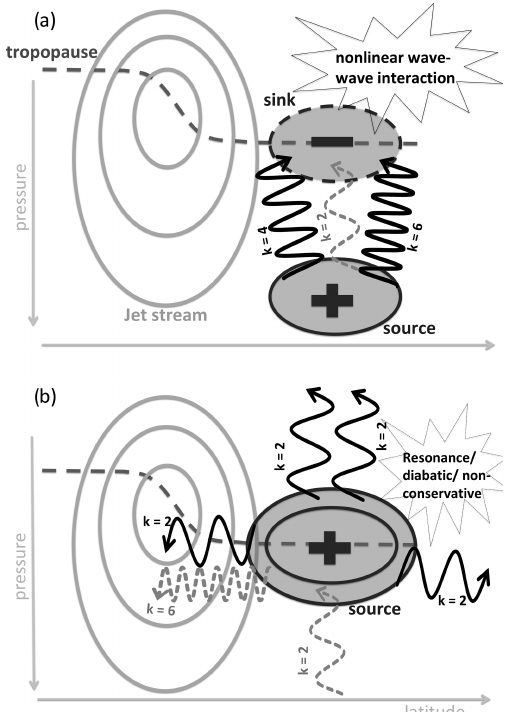
Figure 2. A schematic of upscale cascade at the tropopause in a vertical cross section: (a) smaller-scale waves (e.g., k = 4, 6) show a sink of wave activity (i.e., EP flux convergence) at the tropopause, resulting in nonlinear wave–wave interactions; (b) an enhanced wave source appears in larger-scale waves (e.g., k = 2), caused by upscale cascade, which can be accompanied by resonance, noncon- servative, or diabatic effects, further amplifying the wave source. For detailed description of the processes, see the text. Grey solid contours represent zonal mean zonal wind marking the jet stream; black solid (with plus sign in the middle) and dashed (with minus sign in the middle) ellipses represent wave sources ( ∇ · F > 0) and sinks ( ∇ · F < 0), respectively (the number of contours signifies the strength of ∇ · F ); the thick, dashed, dark grey line represents the tropopause; solid black wiggly arrows (with number of wiggles cor- responding to the wave’s wavenumber k , as labeled) represent the waves (and their propagation direction) that have the most impor- tance at that stage in the process; dashed grey wiggly lines cor- respond to waves that may be present at that stage of the process but are not necessary. Note that the k = 2 upward-propagating wave represented by the dashed grey line in both panels signifies the pres- ence of a k = 2 wave that can interact with the waves generated via upscale cascade, leading to a potential resonant